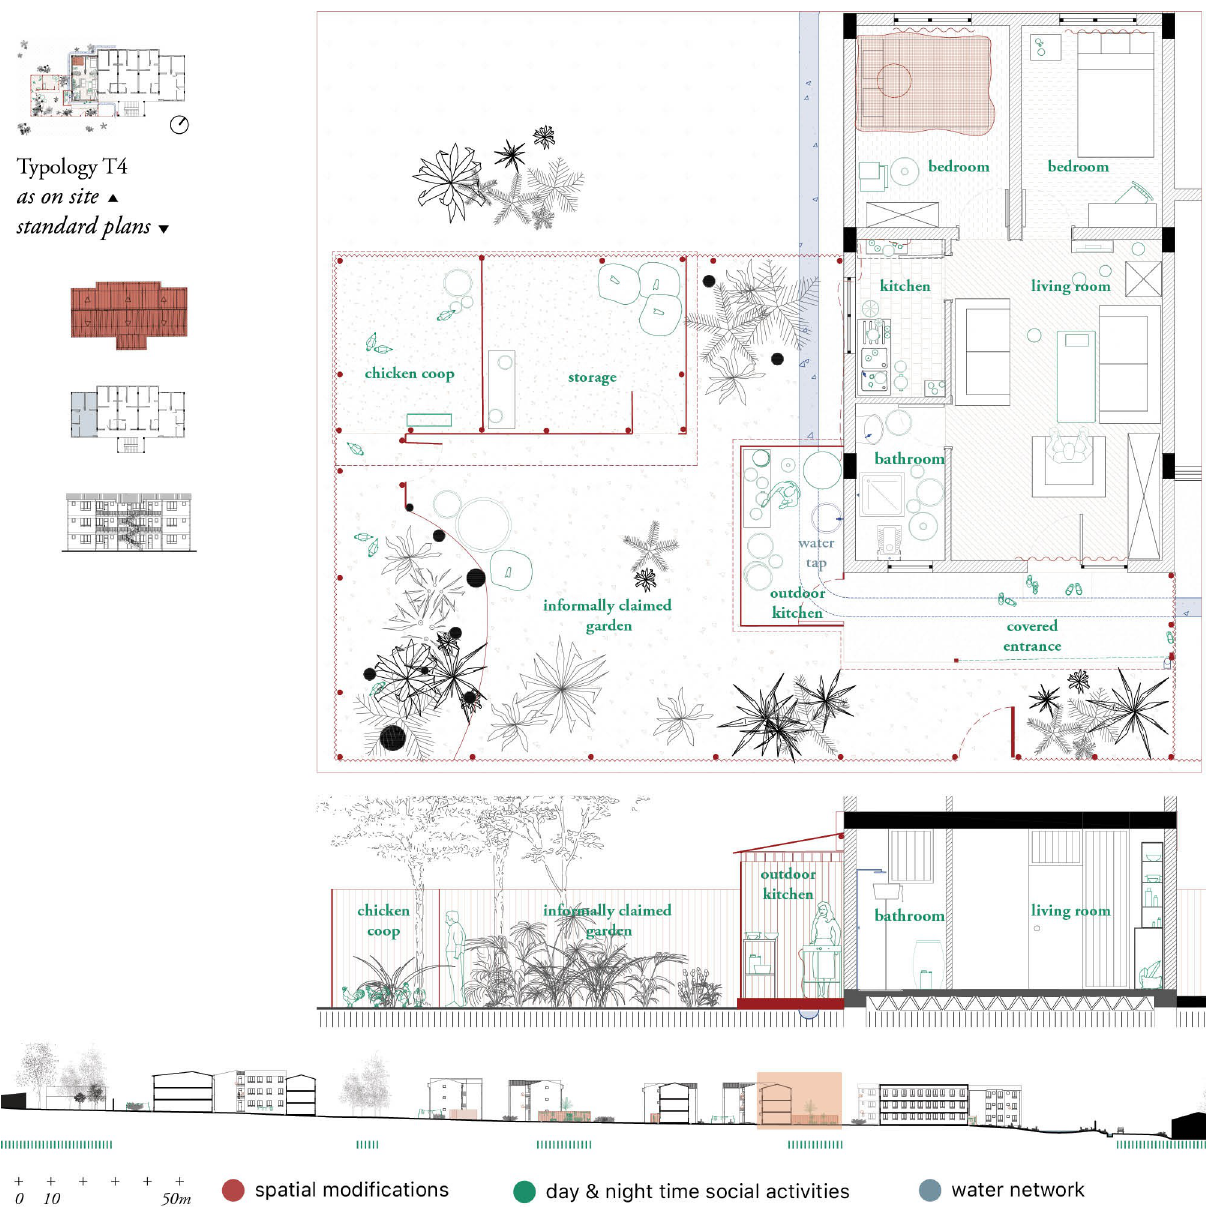
Fig 3. Housing typology with spatial modifications (red), social activities (green) and water network (blue). Structural and non-structural spatial modifications were mapped in red. They comprise informal housing extensions, added doors, removed walls, elevations and adjustments to the windows and other potential mosquito entry points. Spatial mosquito protective measures such as bed nets, curtains and other coverings of holes for screening purposes were also indicated in red,and complemented with socio-cultural activities and practices taking place at day (light green) and night times (dark green), such as cooking or laundering. These observations form a layer of appropriation of either the condominiums common spaces or the standardized housing plan. Finally, a blue layer was added to highlight the water network, including rivers, meanders, canals, and water